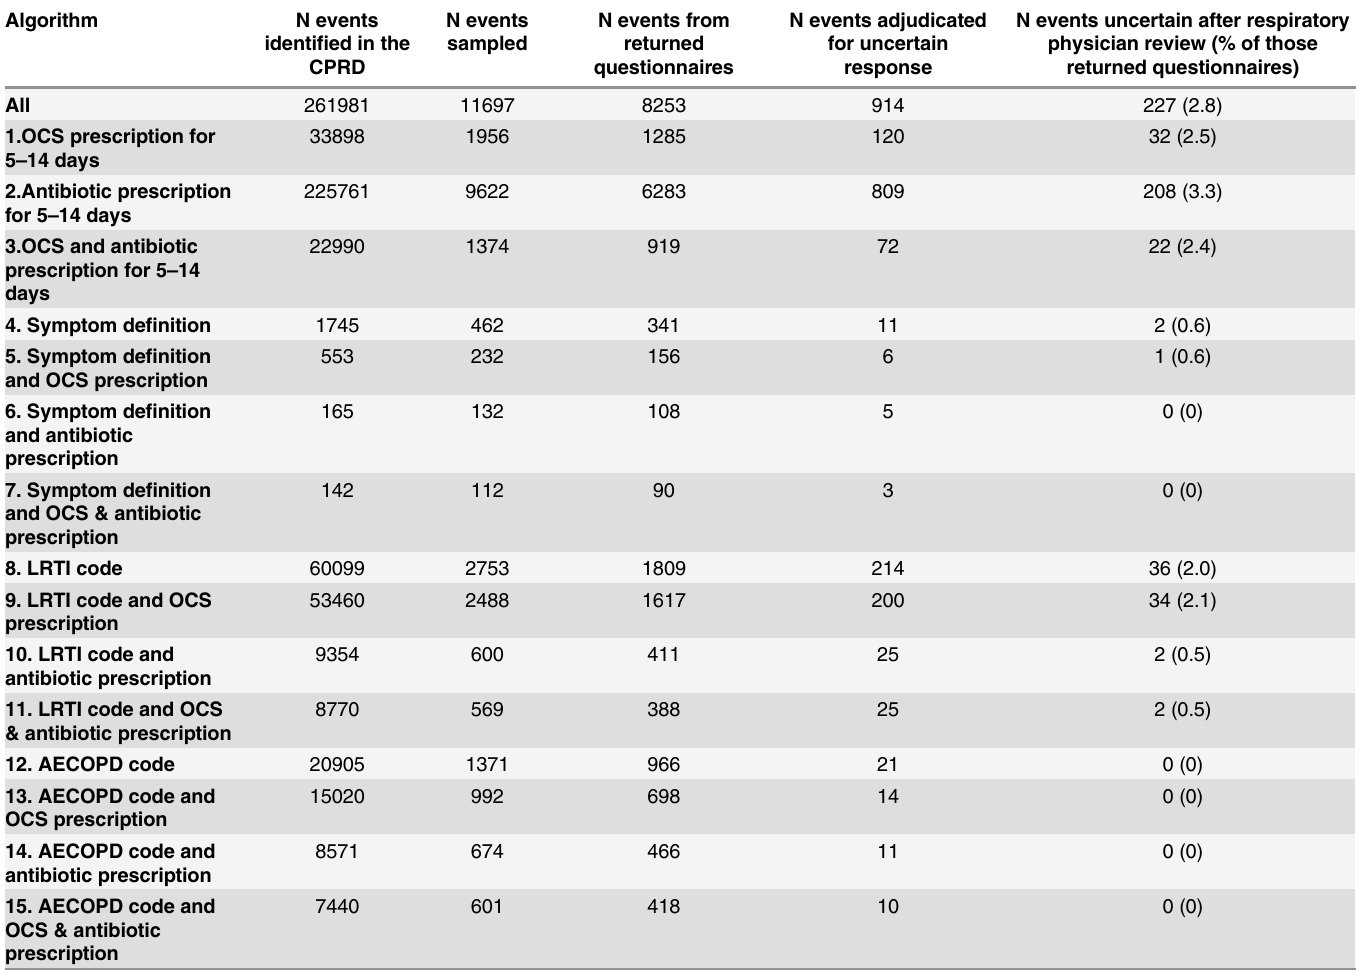
Table 3. Flow of events through the